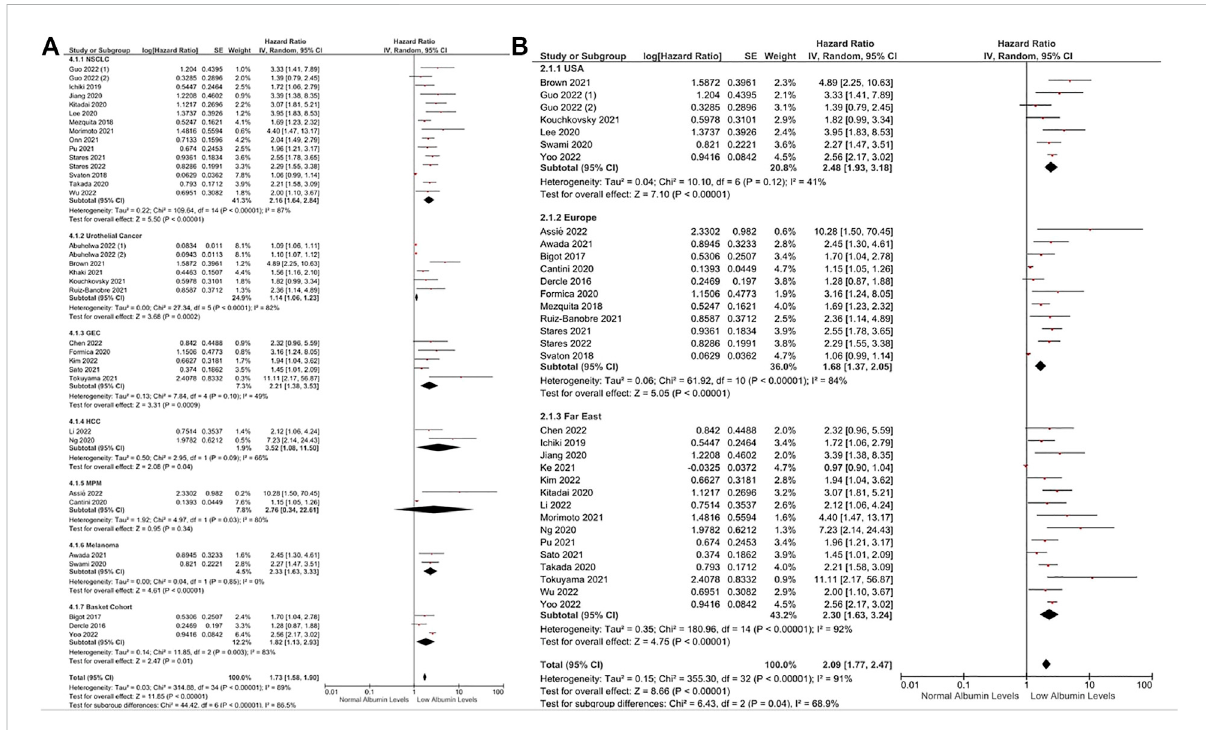
FIGURE 2 Subgroupanalysesaccordingtotumortypes (A) andstudylocation (B) inOS.Lines( ○ )indicate95%CIs.Diamond( ◆ )indicatesthepooledeffect